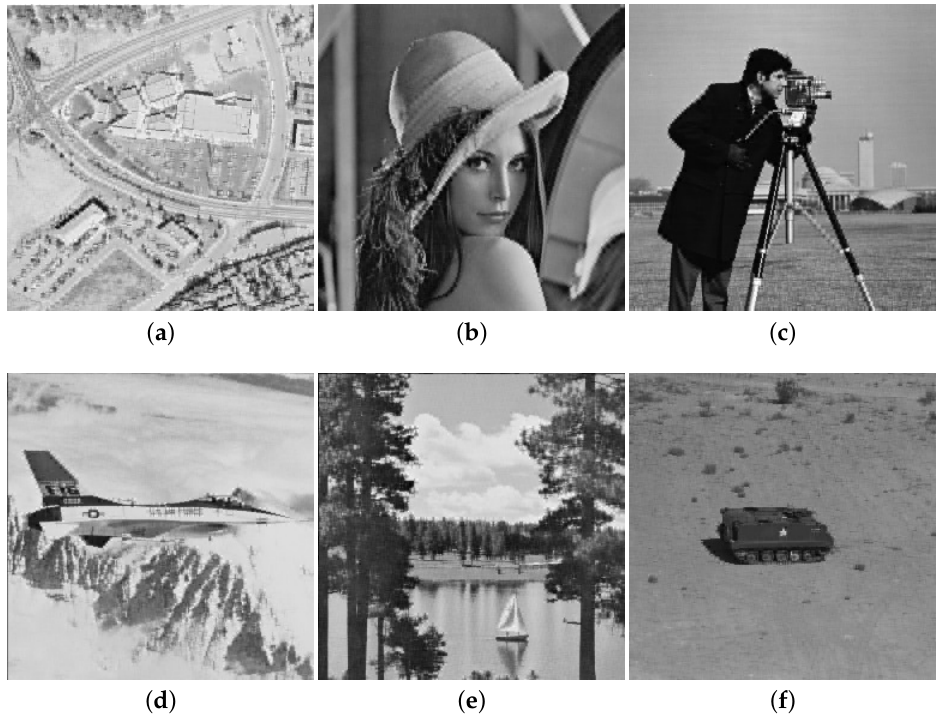
Figure 3. Images reconstructed with only the quarter of singular values. ( a ) aerial; ( b ) lena; ( c ) cam- eraman; ( d ) jet; ( e ) lake; ( f ) tank.